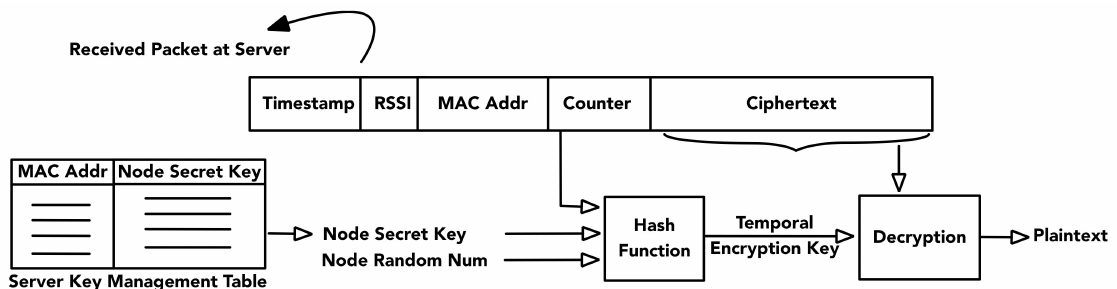
Figure 5. Server/cloud decryption